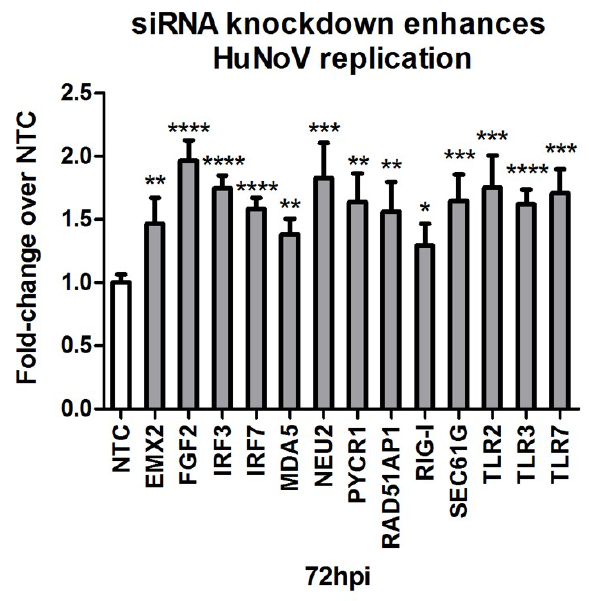
Figure 5. The knockdown of antiviral host gene expression increases GII.4 Sydney HuNoV replication. Treatment with pooled gene-specific siRNAs [50 nM] 48 h before infection resulted in substantial increases in HuNoV titers 72 hpi by qRT-PCR compared to non-targeting control (NTC) siRNA treated cells. Data represent n = 3 + SEM. * p < 0.05, ** p < 0.01, *** p < 0.001, and **** p < 0.0001.